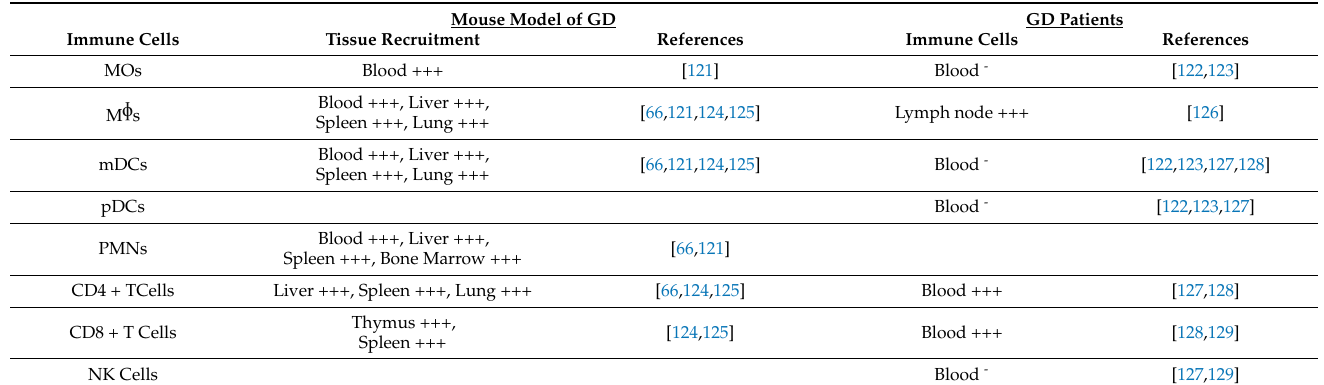
Table 3. Immune cells involvement in